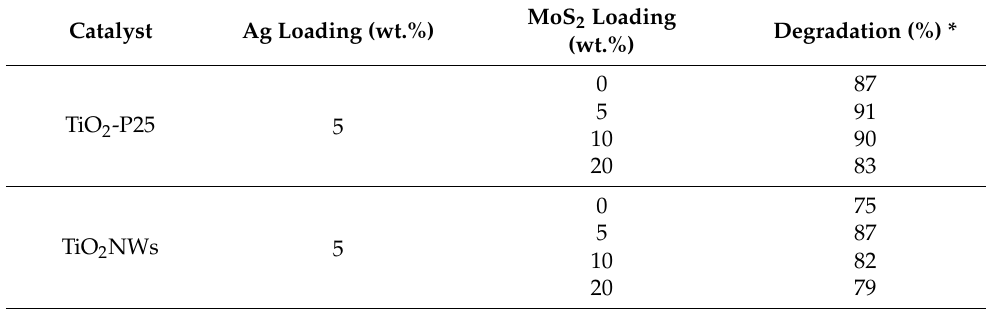
Figure 7. Ciprofloxacin degradation rate (expressed as percent degradation), by using 5%Ag@TiO 2 NWs-X%MoS 2 ( a ) and 5%Ag@TiO 2 -P25-X%MoS 2 ( b ) catalysts. Estimated error is ca. 5%. Table 2. Degradation percentages of ciprofloxacin using silver-based catalysts with different MoS 2 loadings. MoS 2 Loading Catalyst Ag Loading (wt.%)